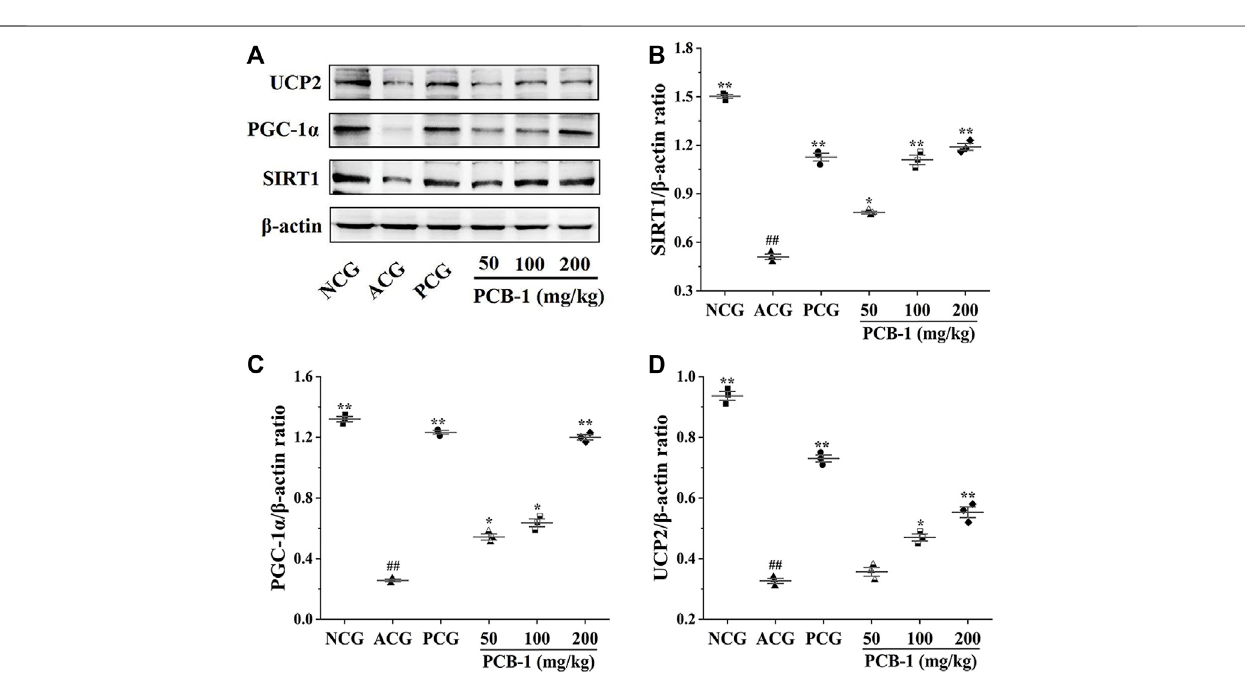
Frontiers in Pharmacology |